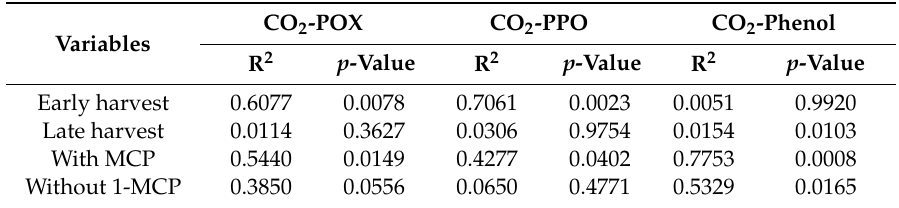
Table 1. Correlation between CO 2 and POX, polyphenol oxidase (PPO) and total phenolic contents of early and late-harvested ‘Empire’ apples with / without 1-MCP at 0.5 ◦ C in air storage up to 7 months and evaluated for 7 days at 20 ◦